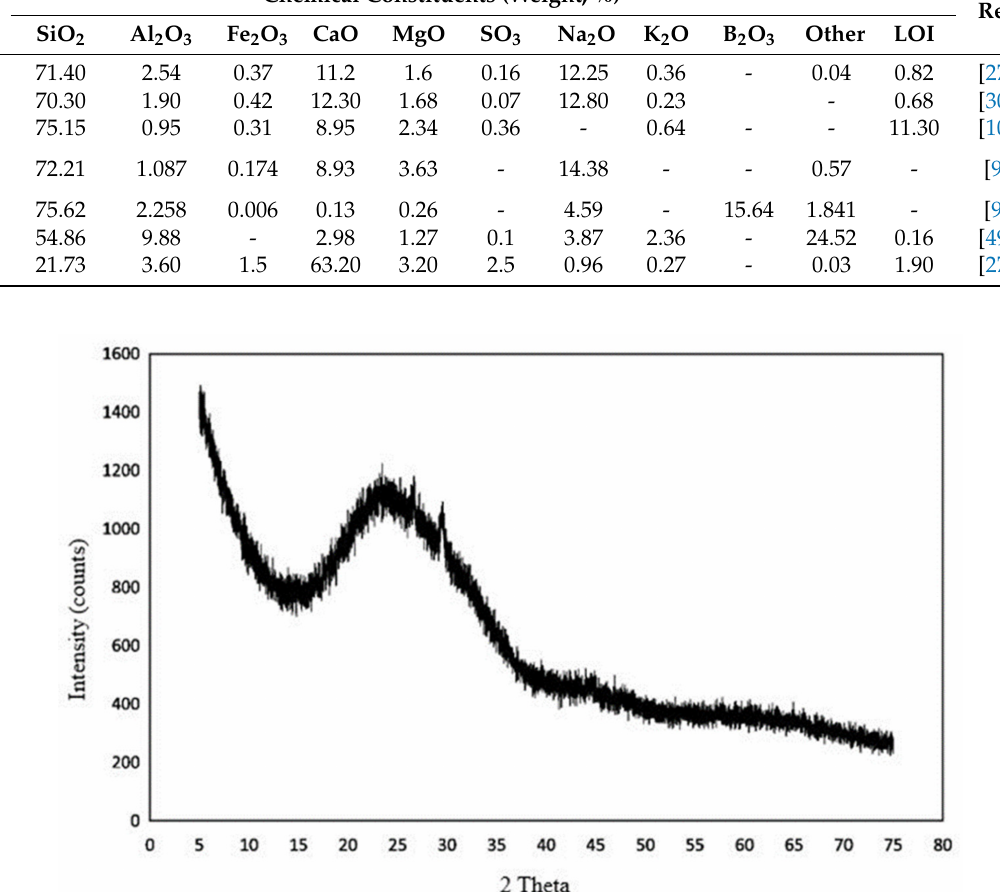
Figure 2. X-ray diffraction pattern for glass powder (windshield glass) (reformatted from